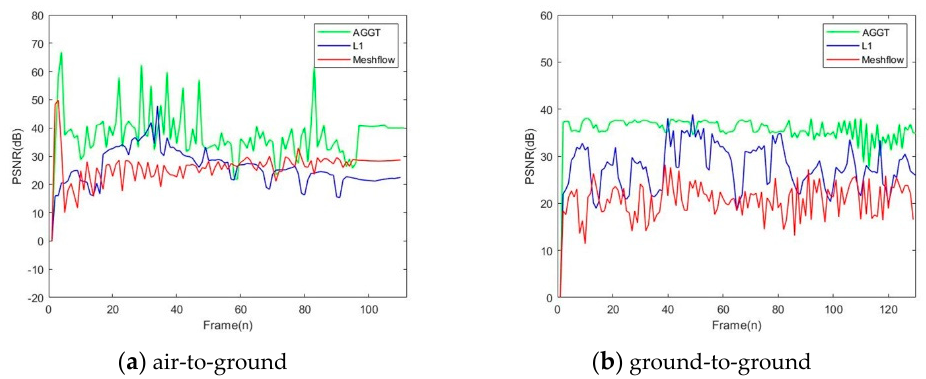
Figure 9. Comparison of the peak signal to noise ratio(PSNR).